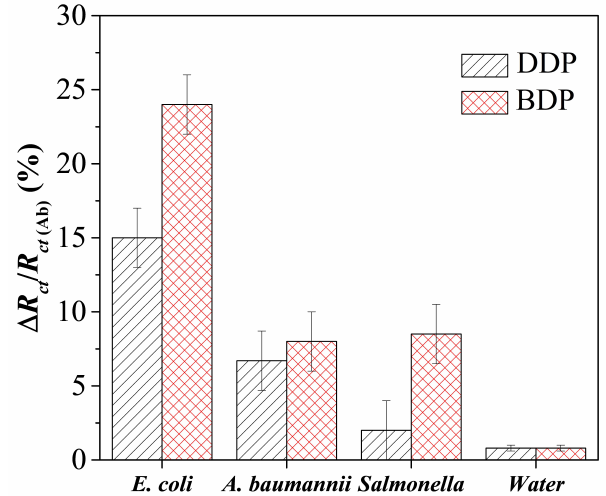
Figure 8. Specificity of the immunosensor in 10 mM Fe(CN) 63 − / 4 − solution at pH 7.4. ∆ R ct / R ct (Ab) induced by 10 5 CFU mL − 1 E. coli in comparison with the negative control (drinking water) and non-target bacteria ( Acinetobacter baumannii and Salmonella enteriditis 706 RIVM